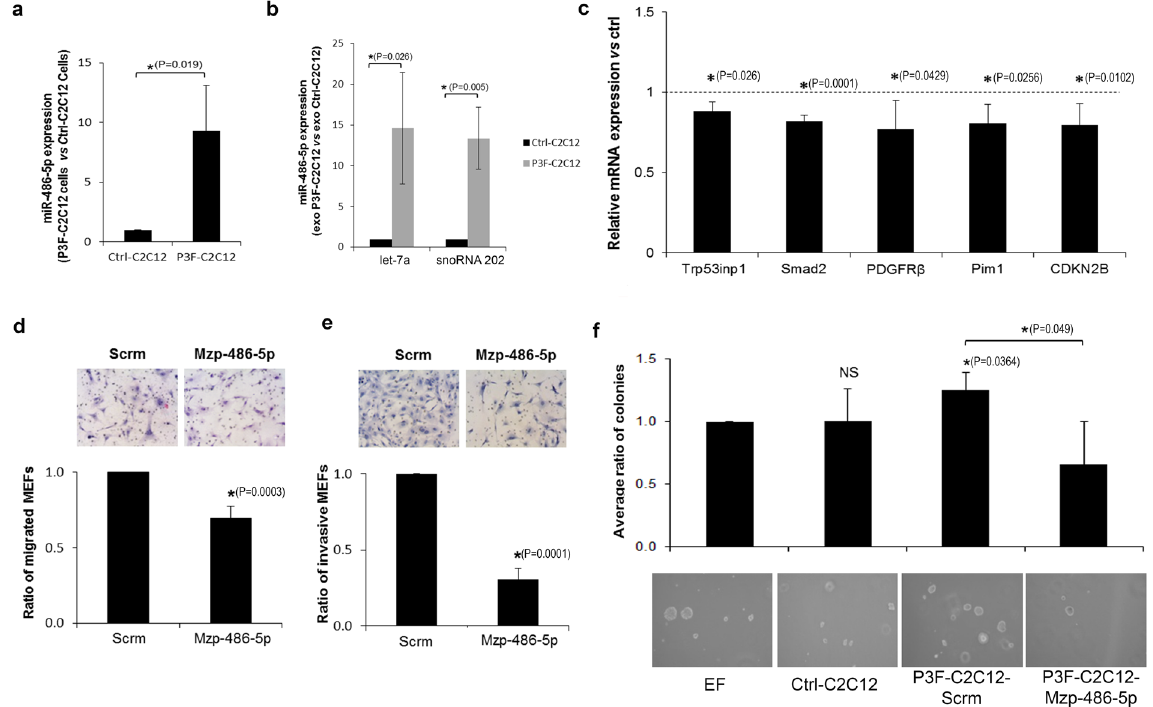
Figure 4. miR-486-5p is a downstream effector of PAX3-FOXO1 exosome-mediated effects. ( a , b ) qRT-PCR analysis of miR-486-5p expression in ( a ) P3F-C2C12 cells and ( b ) their derived exosomes, relative to Ctrl- C2C12 cells and their derived exosomes, respectively, using 2 distinct internal controls, let-7a and snoRNA202 ( c ) Relative expression of miR-486-5p known targets that were significantly downregulated in MEFs treated for 48 h with P3F-C2C12 exosomes normalized to those treated with Ctrl-C2C12 exosomes as detected by qRT-PCR.GAPDH was used as internal control. ( d , e ) Migration ( d ) and invasion ( e ) of MEFs treated with 10X exosomes extracted from P3F-C2C12 cells transduced either with negative control ( Scrm ), or with knockdown of miR-486-5p by MiRZip-486 ( Mzp-486-5p ), as indicated. Histograms represent ratio of the denoted conditions versus control. ( f ) Ratio of number of colonies formed by P3F-C2C12 cells after treatment with the specified exosomes at 10X, to that of cells treated with control exosome-free media. Representative microscope images are of colonies at 3 weeks. Values are mean ratio of three independent experiments. Bars represent standard deviation. Asterisks denote a statistically significant difference (p-value <